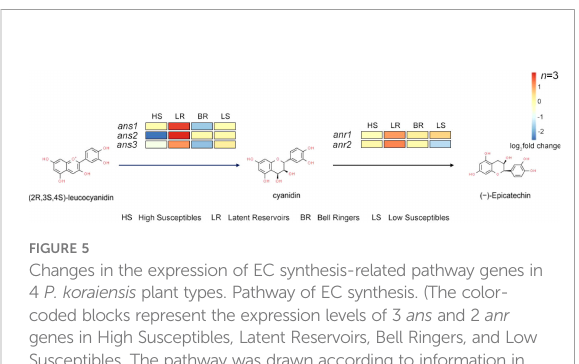
FIGURE 5 Changes in the expression of EC synthesis-related pathway genes in 4 P. koraiensis plant types. Pathway of EC synthesis. (The color- coded blocks represent the expression levels of 3 ans and 2 anr genes in High Susceptibles, Latent Reservoirs, Bell Ringers, and Low Susceptibles. The pathway was drawn according to information in literature and the KEGG database